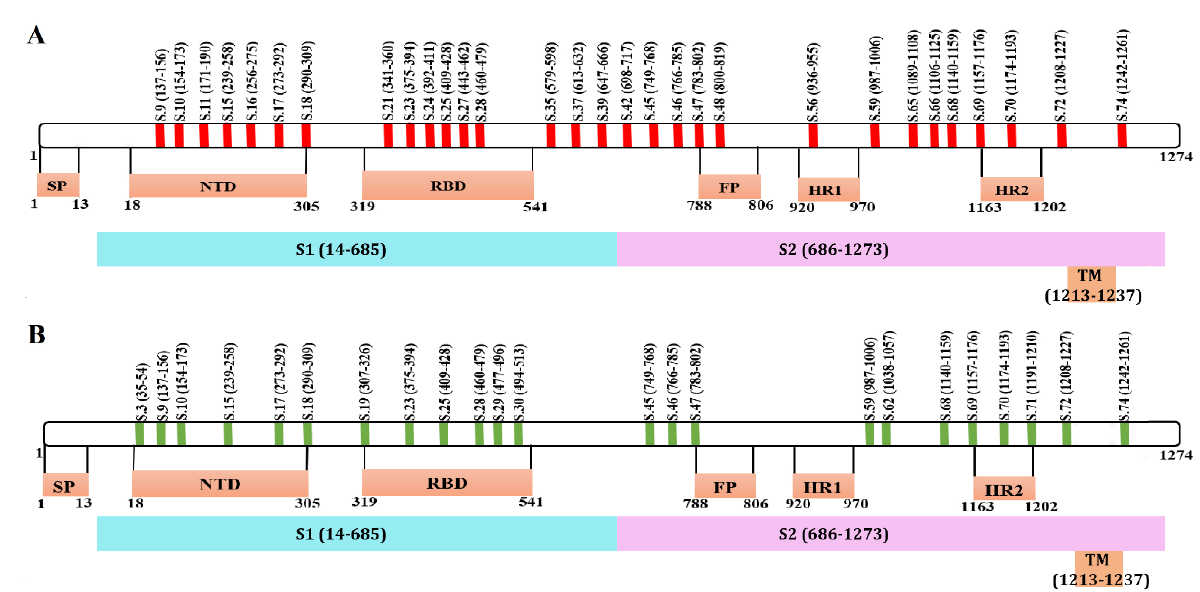
Figure 4. Schematic presentation of SARS-CoV-2 S protein peptides reacting with SputnikV immunized and convalescent COVID-19 sera. Location of peptides recognized by ( A ) SputnikV immunized serum and ( B ) convalescent COVID-19 sera.